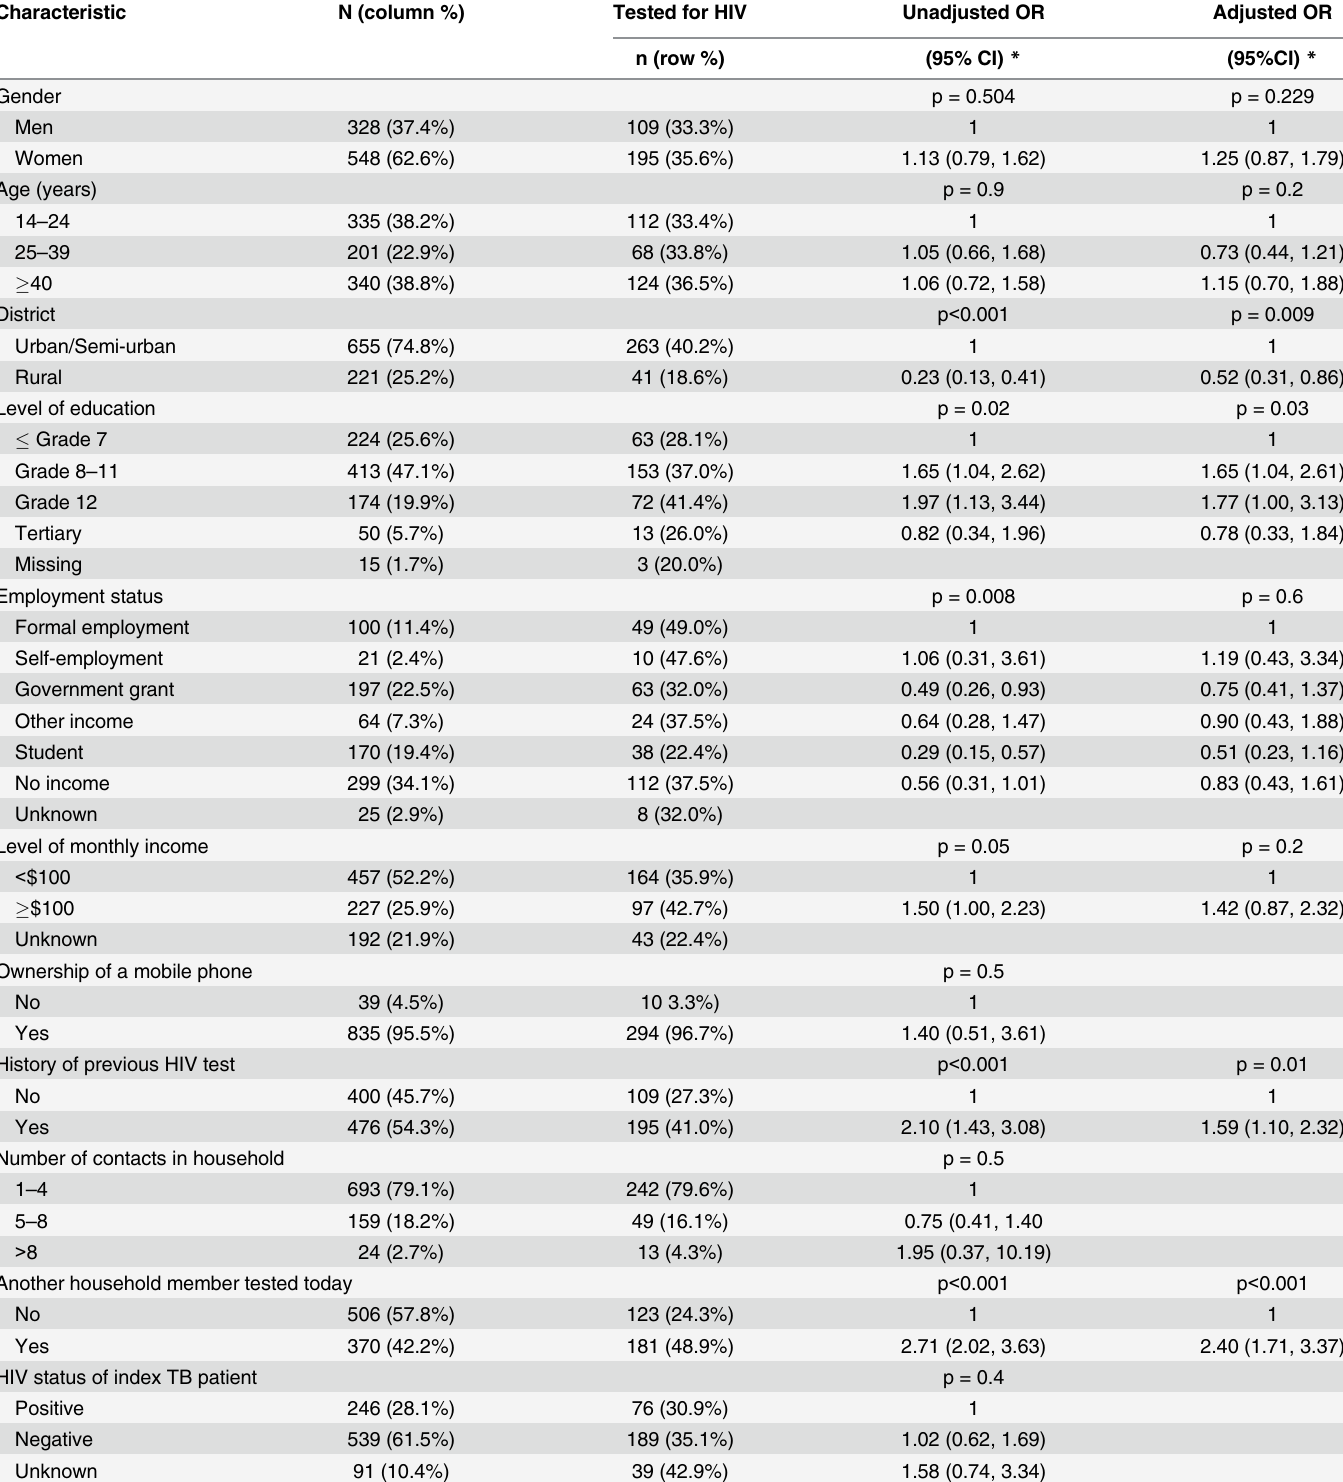
Table 1. Demographic characteristics of household contacts who were offered an HIV test (n =